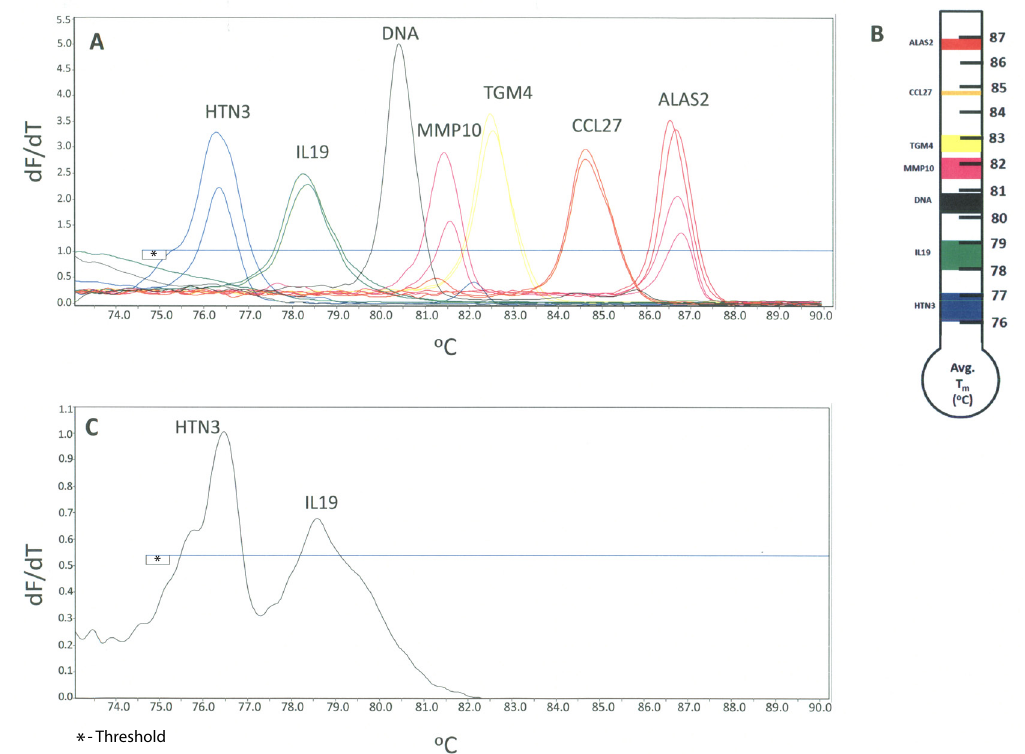
Figure 6. ‘All body fluids’ hexaplex HRM body fluid assay. A ) Derivative melt curve plots for the hexaplex assay is shown: saliva (HTN3, blue), vaginal secretions (IL19, green), menstrual blood (MMP10, pink), semen (TGM4, yellow), skin (CCL27, orange), and blood (ALAS2, red). Two donors of each body fluid or tissue are shown. The melt plots shown are overlaid single source melt plots with all individual samples analyzed using the respective multiplex HRM assays (shown overlaid to demonstrate marker positions within the multiplex assay). The location of a peak originating from contaminating DNA (IL19) is shown in black. B ) Hexaplex biomarker resolution as represented by the T (°C) range (average